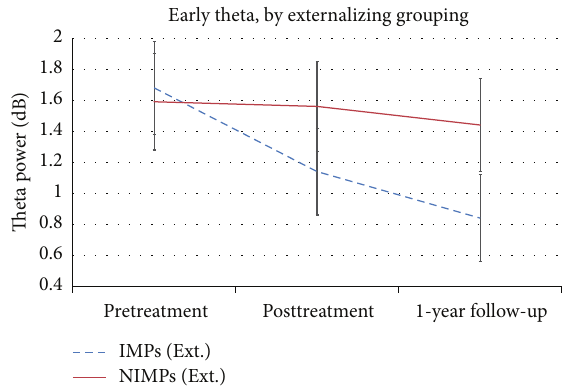
Figure 2: Line plot showing early theta power (in dB) for the externalizing (Ext.) grouping across all session time points broken down for improver status. NIMPs: nonimprovers; IMPs: